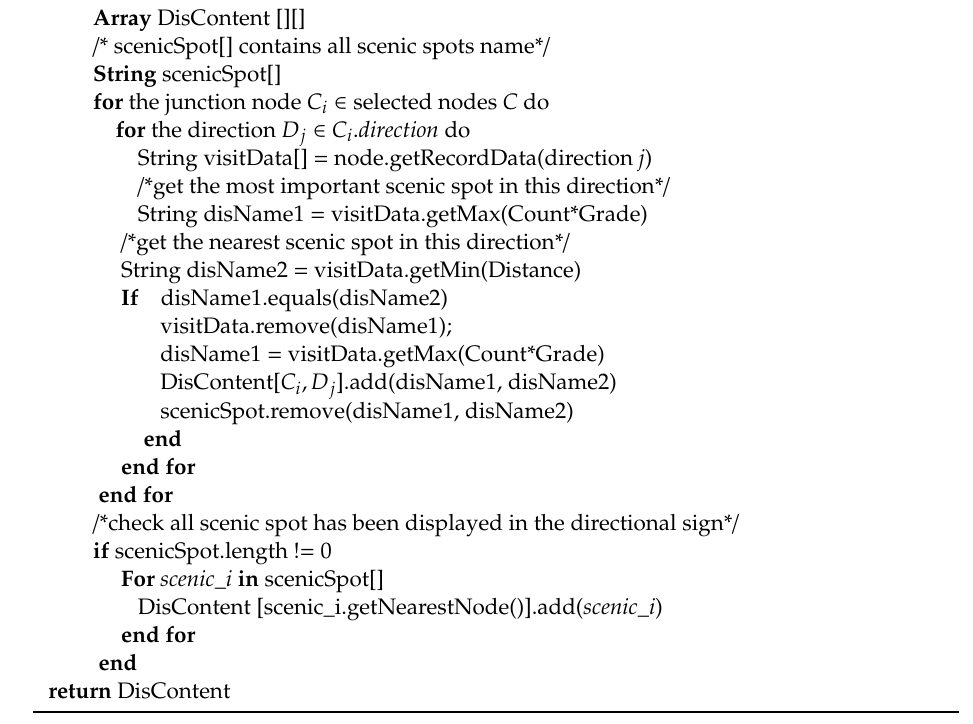
Table 2. Content generation process of each junction